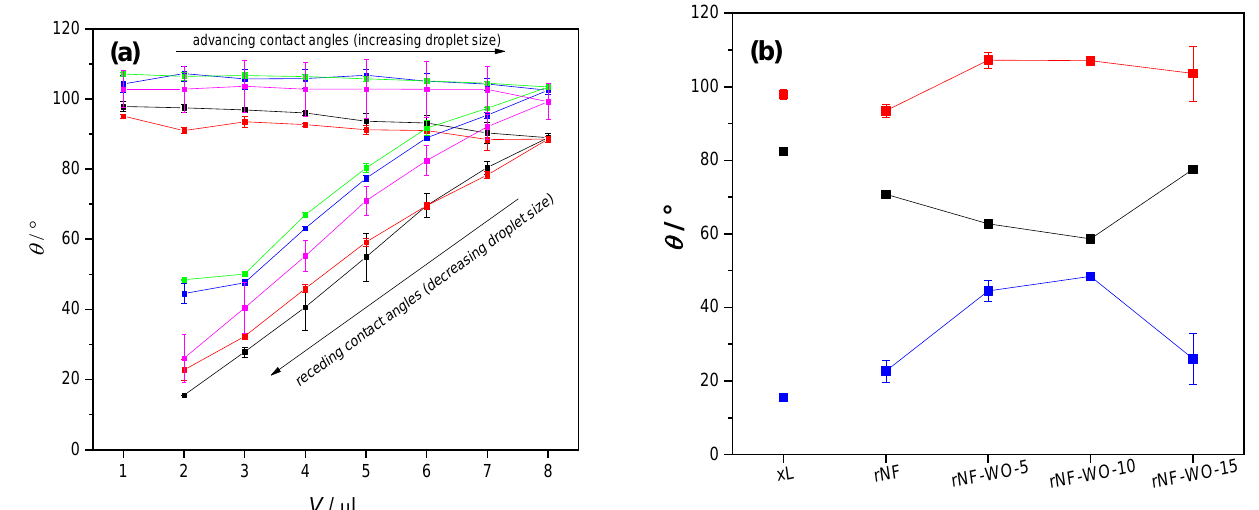
Figure 8. ( a ) Mean advancing and receding CAs with standard errors of three parallel measurements as a function of droplet volume, Nafion XL commercial membrane (black), recast Nafion membrane (red), Nafion membrane with 5, 10, and 15 wt% tungsten oxide (blue, green, and purple, respectively); ( b ) Maximum mean advancing ( θ max —red) and minimum mean receding ( θ min —blue) CAs with standard errors of three parallel measurements, and the CA hysteresis ( ∆ θ = θ max − θ min — black).